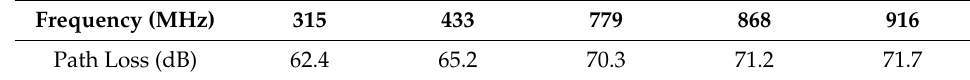
Table 5. Path loss at different frequencies.